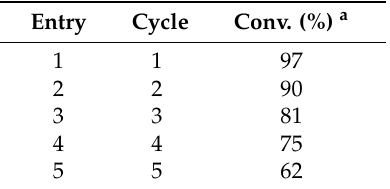
Table 3. Reusability of the Au–SILP catalyst.